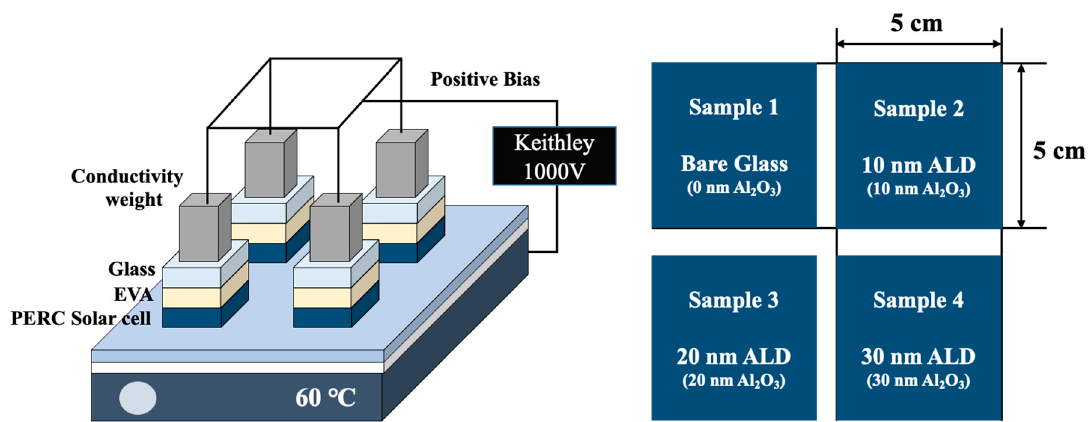
Figure 1. Schematic of the accelerated PID test. A 2 kg weight made of aluminum was used. Four module-like stack samples were tested at the same time. After 96 h, each stack was disassembled, and I-V measurements were performed.